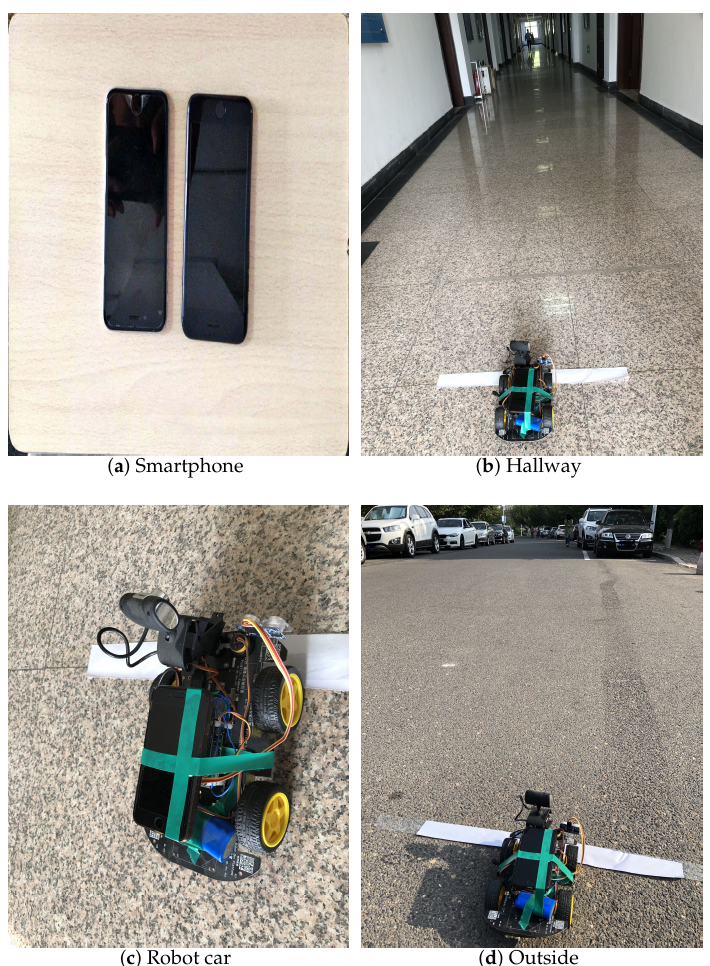
Figure 9. Indoor experiment